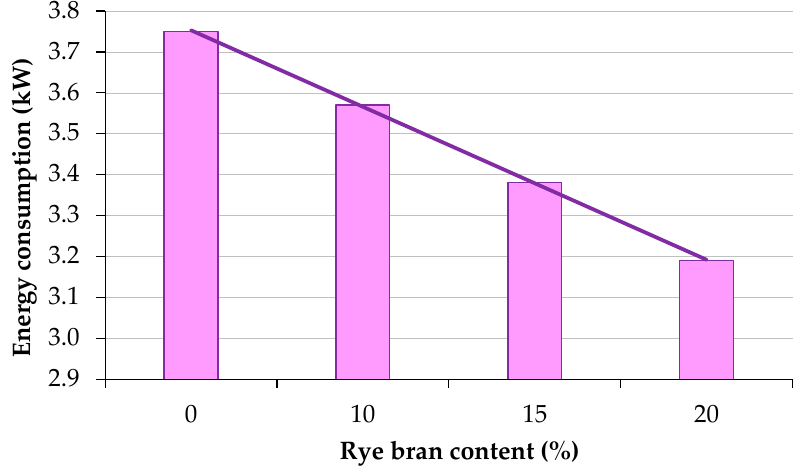
Figure 3. Energy consumption during the pelletization of sage waste biomass with different rye bran